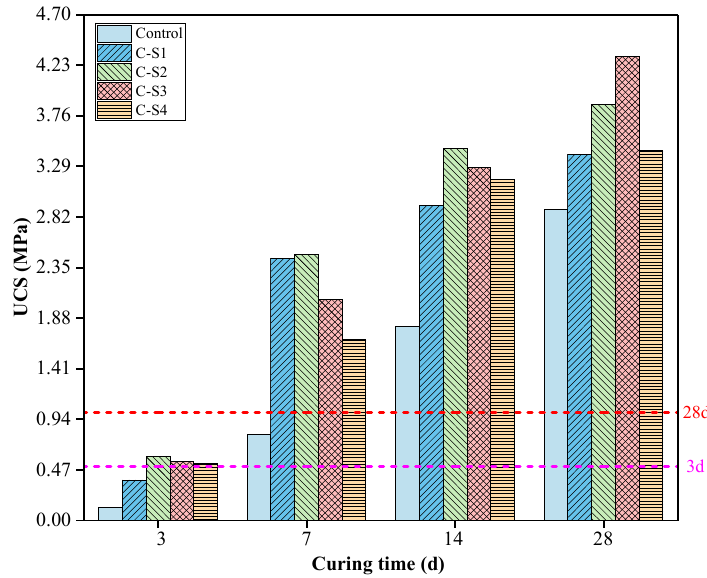
Figure 6. E ff ect of Na 2 SO 4 dosage on the UCS of PCCPB. Figure 6. Effect of Na 2 SO 4 dosage on the UCS of Table 3. The statistical analysis of UCS results.